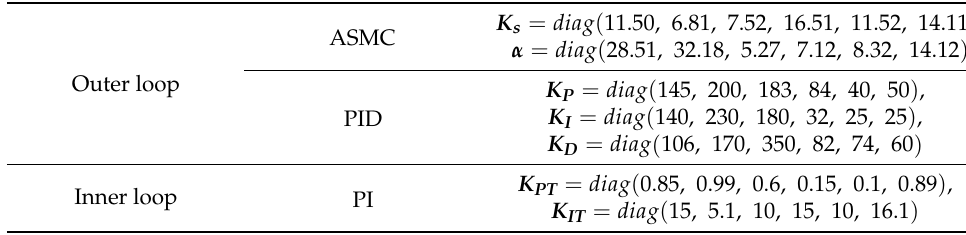
Table 7. The controllers’